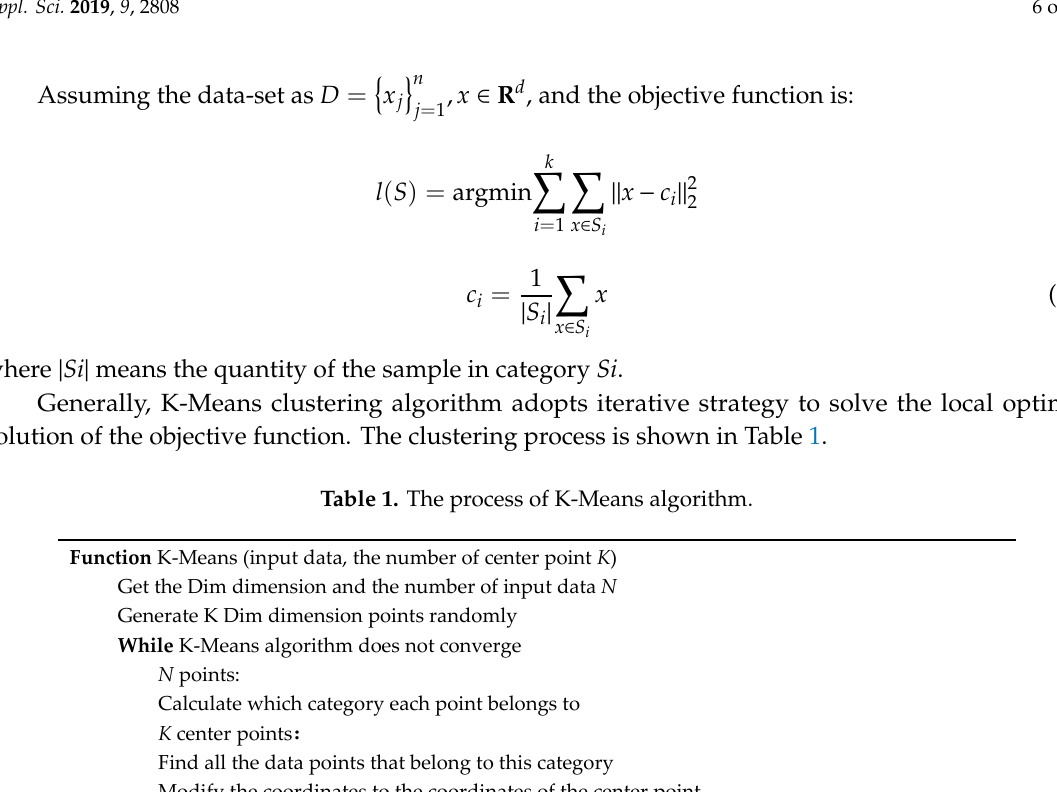
( b ) Figure 4. Two adjacent images captured by UAV: ( a ) the first image; ( b ) the second image. Step 2 : feature extraction and generation of regions of interest.